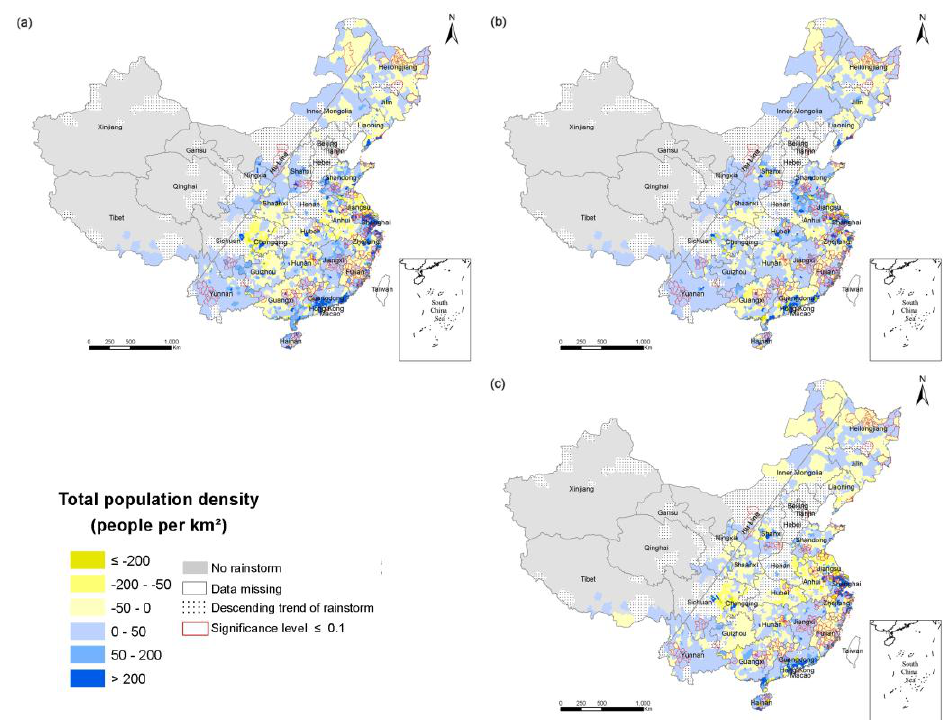
Figure 6. The change in the density of the total population in the RSHA ( a ) from 1900 to 2010; ( b ) from 1990 to 2000; ( c ) from 2000 to 2010.